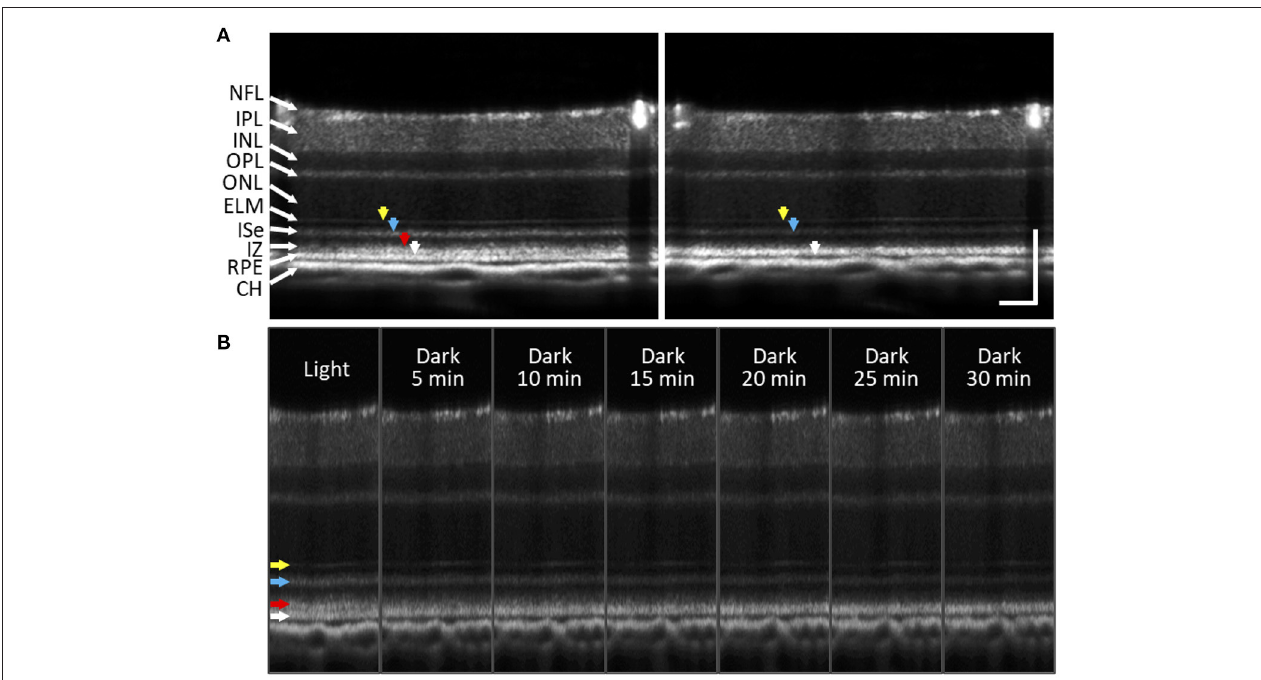
FIGURE 9 | Subretinal space changes during dark adaptation in the mouse retina. (A) OCT images of light- and dark-adapted retina of a two-month-old C57BL/6J mouse. Color arrows to indicate outer retinal bands: 1st ELM band (yellow), 2nd ISe band (blue), 3rd IZ and OS tip band (red), 4th RPE band (white). (B) A sequence of OCT images obtained every 5min up to 30min during dark adaptation. During dark adaptation, ISe intensity reduction rapidly occurred, and the SRS became thinner. In addition, the 3rd outer retinal band (red arrow) faded over time. NFL, nerve fiber layer; IPL, inner plexiform layer; INL, inner nuclear layer; OPL, outer plexiform layer; ONL, outer nuclear layer; ELM, external limiting membrane; ISe, inner segment ellipsoid; IZ, interdigitation zone; RPE, retinal pigment epithelium; CH, choroid. Scale bars: 100 µ m. Modified with permission from Kim et al. ( 65).